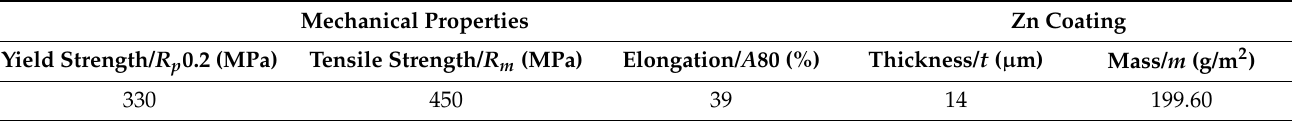
Table 2. Mechanical and coating attributes of the BH 220 steel.